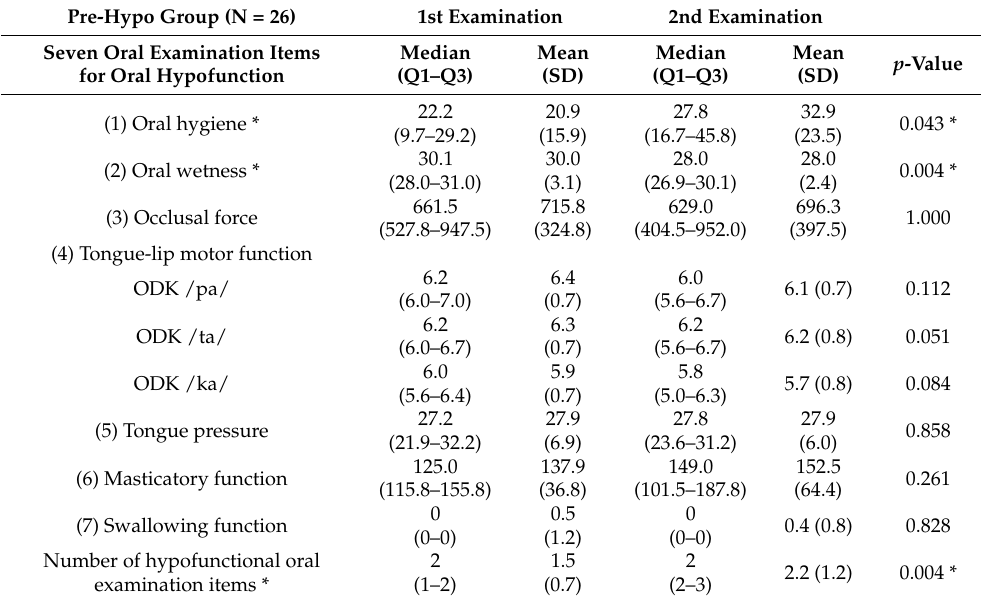
Table 3. Temporal changes in oral function between 1st and 2nd examination in the Pre-hypo group. Pre-Hypo Group (N =